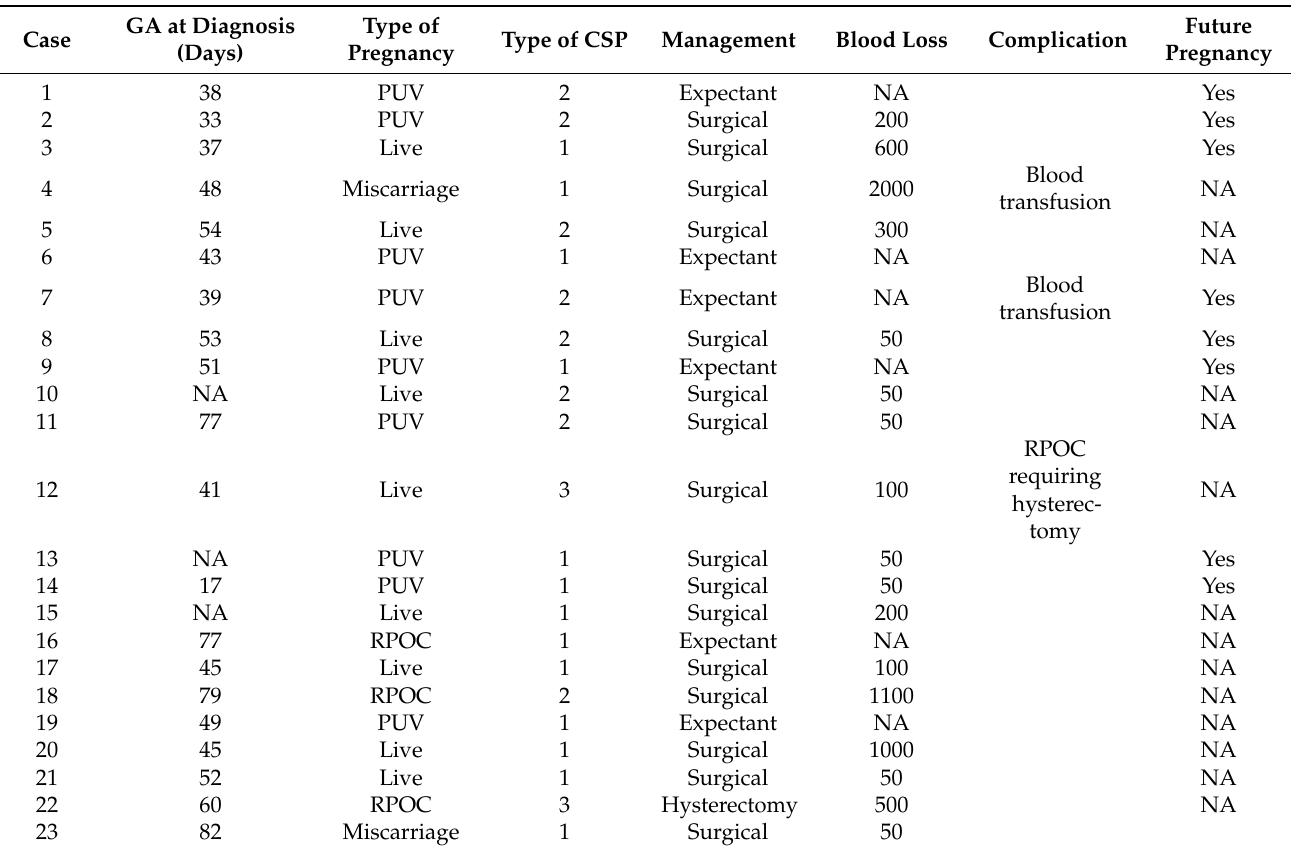
Table 2. Management of the 23 Caesarean Scar Pregnancy cases.